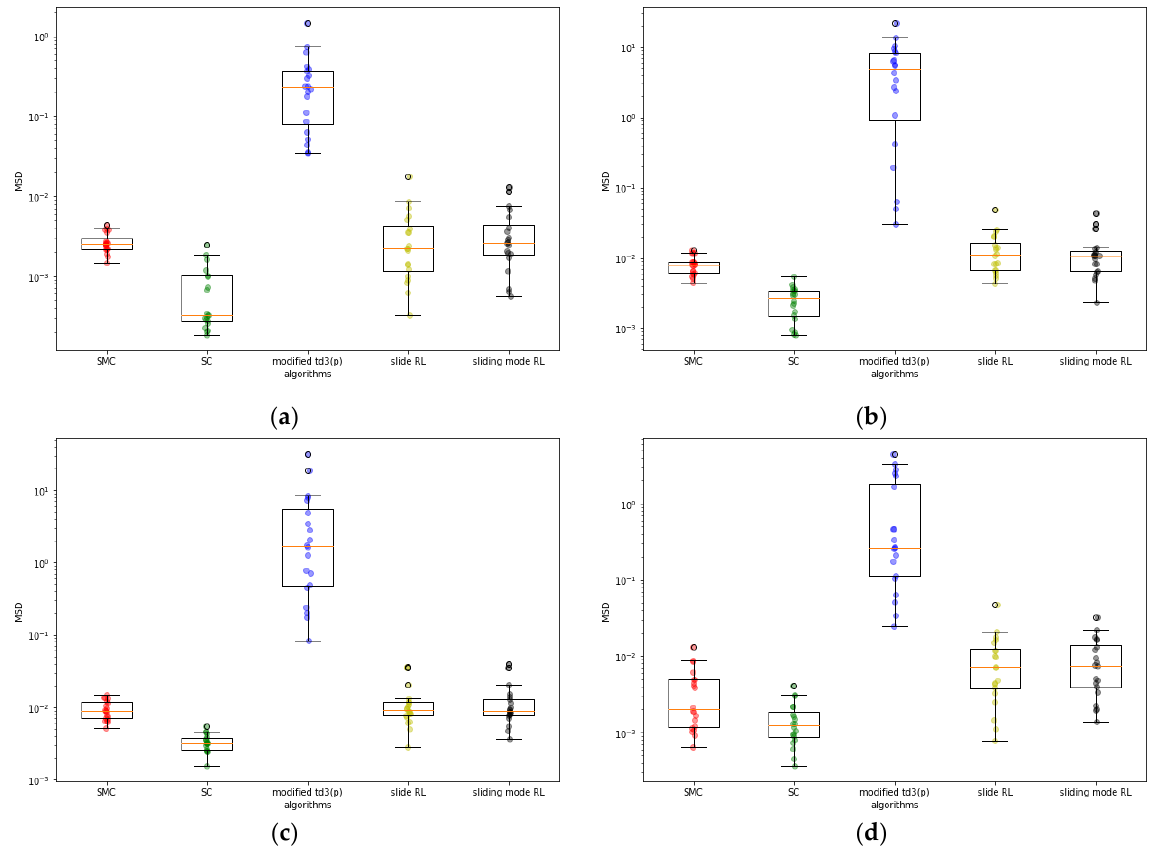
Figure 5. Box plot of MSDs: ( a ) case1; ( b ) case3; ( c ) case4; ( d ) case6.